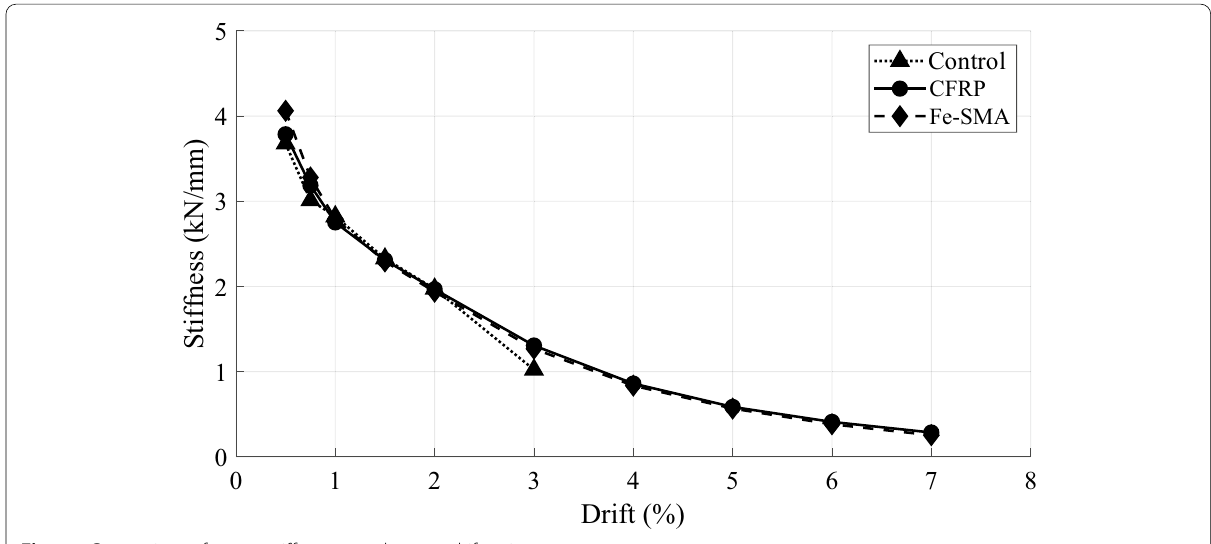
Fig. 11 Comparison of secant stiffness at each target drift